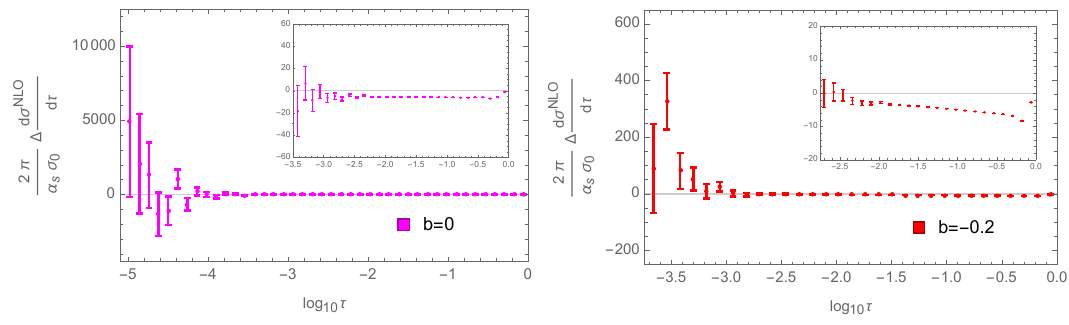
II factorization